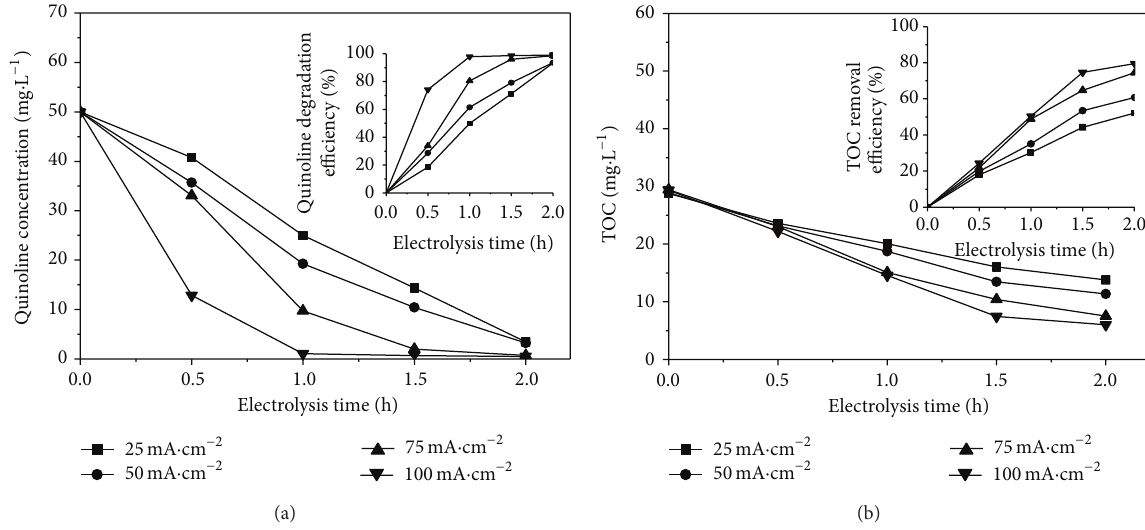
Figure 1: Effect of current density on quinoline degradation (a) and TOC removal (b).